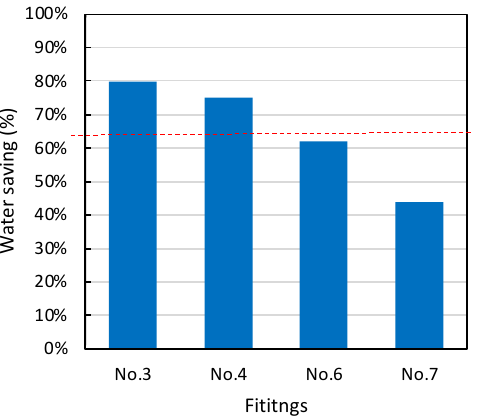
Figure 10. Average water savings of fittings ( n = 4 for each type). Note: The red dashed line is the average of the four fittings.